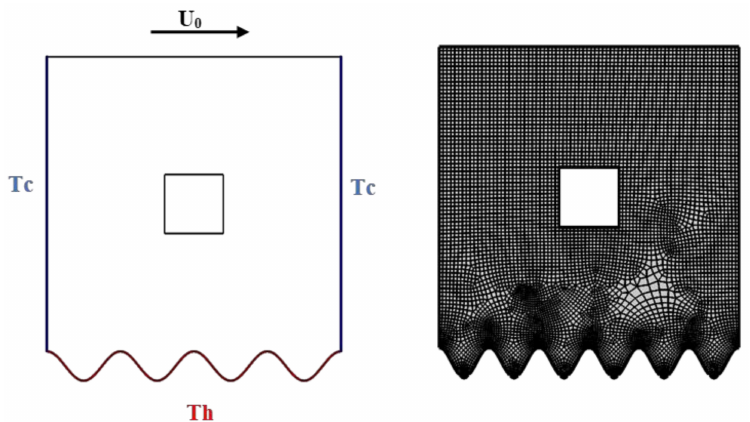
Figure 1. Physical domain and